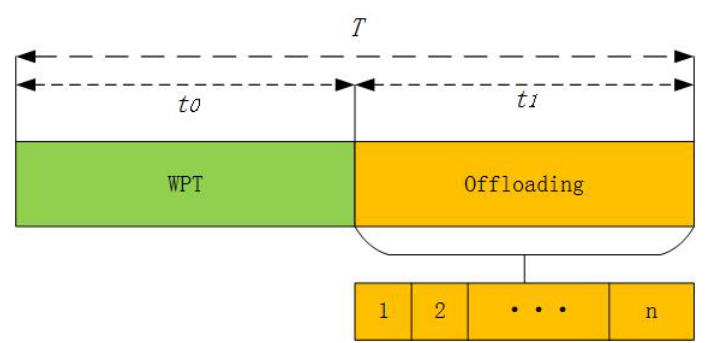
Figure 2. Time-division multiplexing model for energy harvesting and task